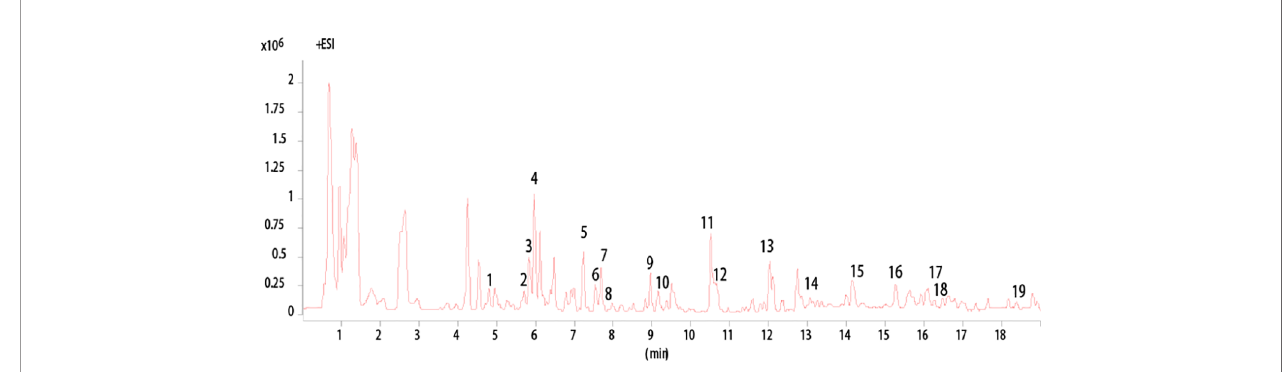
FIGURE 1 | HPLC analysis of AAM extract. Base Peak chromatogram from HPLC Q-TOF/MS analysis of the ethanol extract of AAM (positive ions).